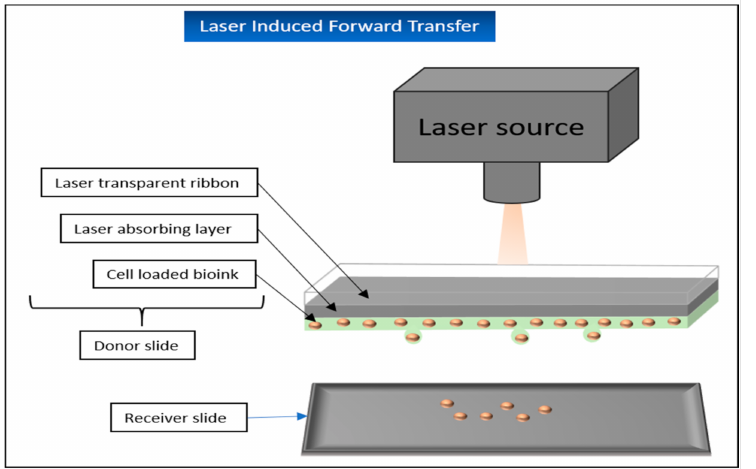
Figure 11. Schematic representation of the laser induced forward transfer. Printing material is located on a specially prepared “donor slide” and is sprayed onto a “receiver slide” in droplet form with under usage of a laser